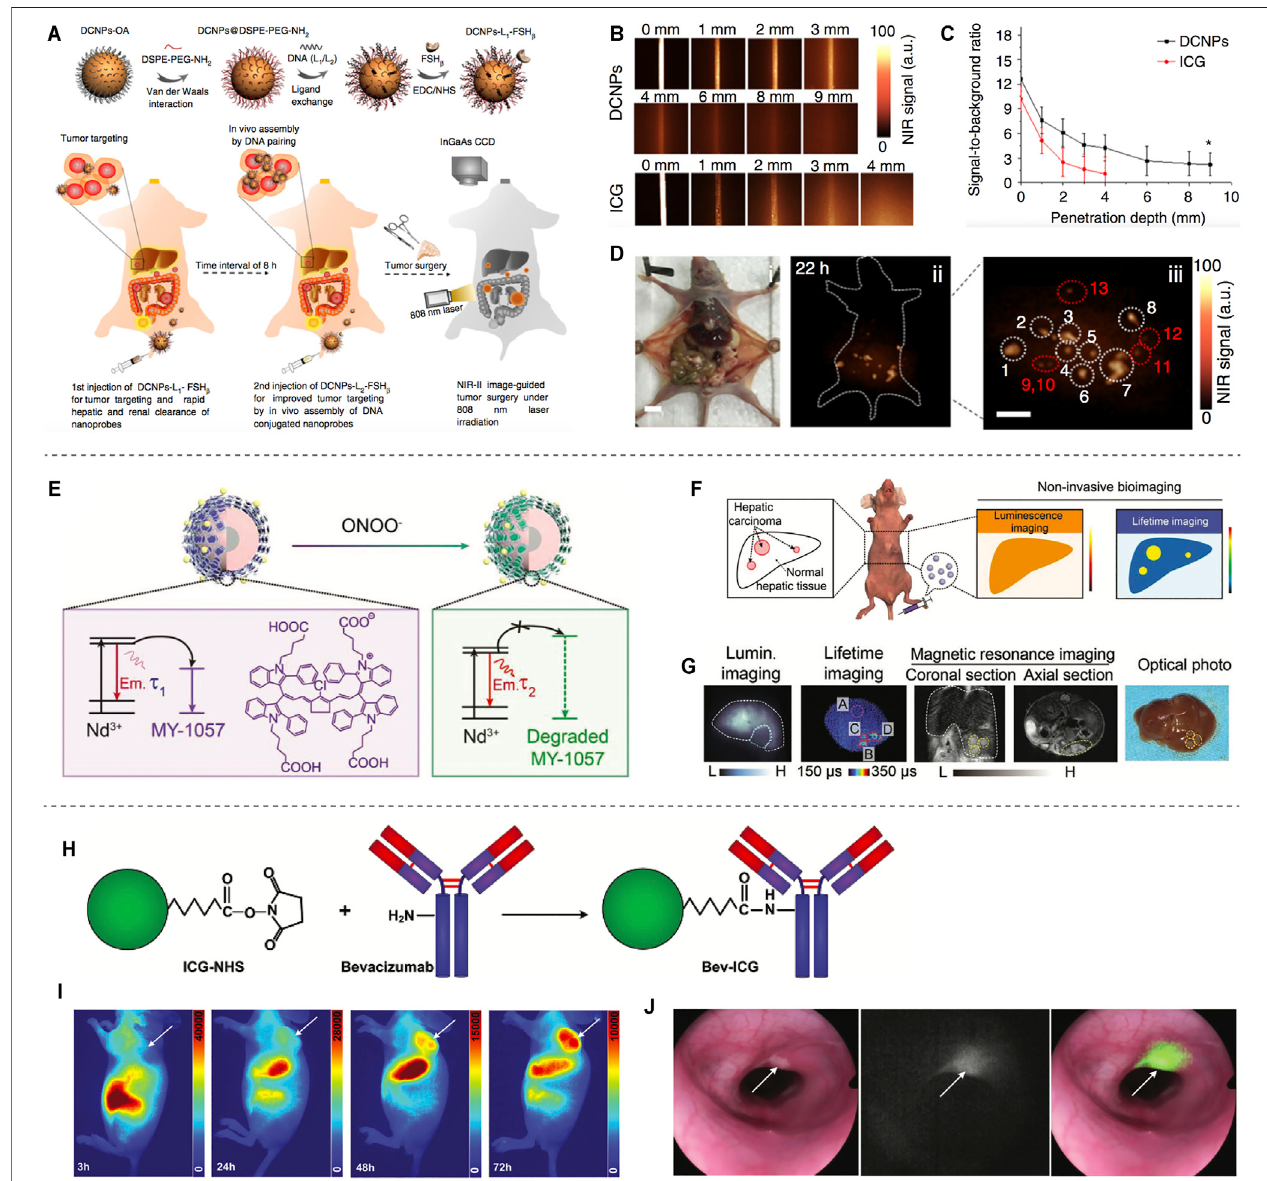
FIGURE 2 | NIR-II based Tumor delineation and image-guided surgery. (A) Schematic illustration of DNA and FSH β modi fi ed DCNPs and in vivo assembly of DCNPs with improved tumor navigation and excision. (B) The penetration depth of DCNPs and ICG of phantom tissues. (C) Signal to background ratio of DCNPs and ICG. (D) TheNIR-IInanoparticleslabeledperitonealmetastatictumors(reproducedfrom(Wangetal.,2018)withpermissionfromSpringerNature). (E) Inthepresenceof ONOO − ,MY-1057degradessensitively,leadingtothelifetimerecoveryofNIR-IIregion. (F) IllustrationofNIR-IIluminescenceandlifetimeimagingforhepatocellular carcinomas. (G) Noninvasive luminescence imaging, lifetime imaging and MRI of hepatocellular carcinomas, and optical photo of the dissected liver (reproduced from (Zhao et al., 2020) with permission from John Wiley and Sons). (H) Synthesis process of Bev-ICG. (I) Whole body NIR-II fl uorescence imaging of mice after injection of Bev-ICG. (J) Simultaneous white-light and fl uorescence images of tumors (reproduced from (Suo et al., 2019) with permission from John Wiley and Sons).